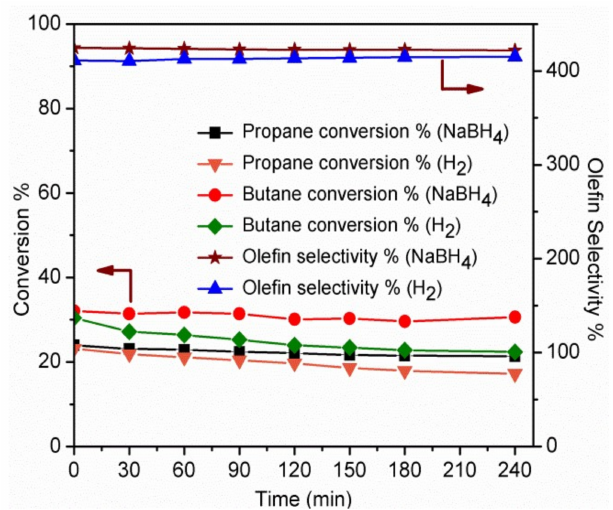
Figure 6. Conversion and Selectivity over the NaBH 4 and H 2 reduced catalysts for mixed-para ffi n feed. Table 3. Conversion and selectivity mixed para ffi n feed dehydrogenation after 240 min. Dehydrogenation Parameter a NaBH 4 Reduced Catalyst Hydrogen Reduced